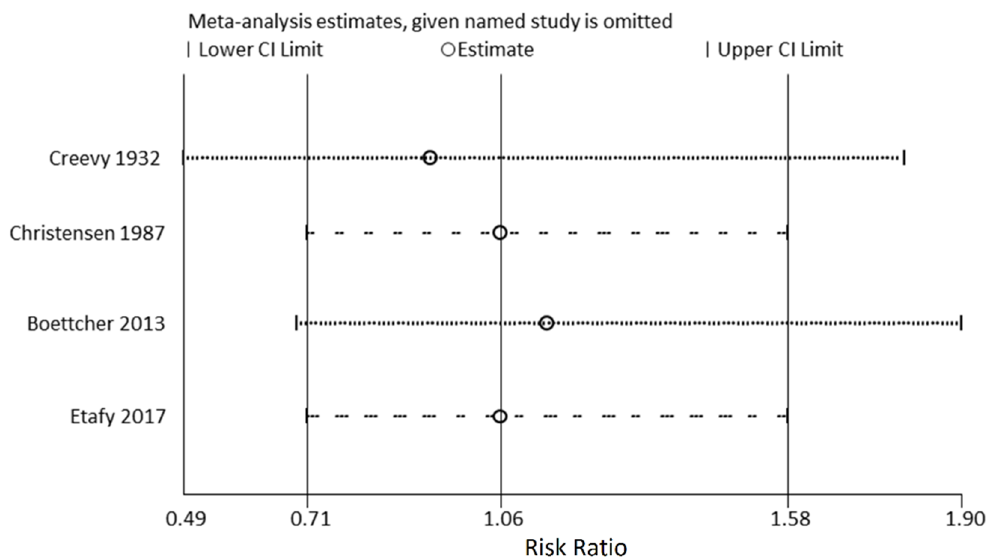
Figure 5. Sensitivity analysis for hematuria. CI, confidence interval.